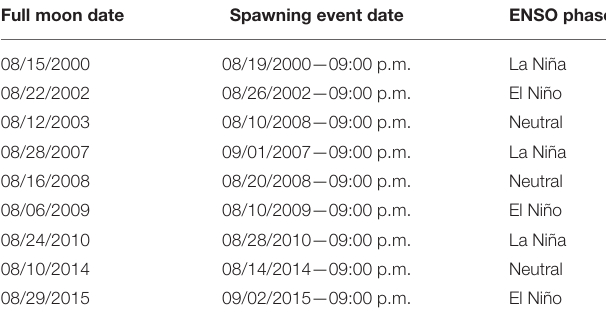
TABLE 1 | Full moon and spawning event